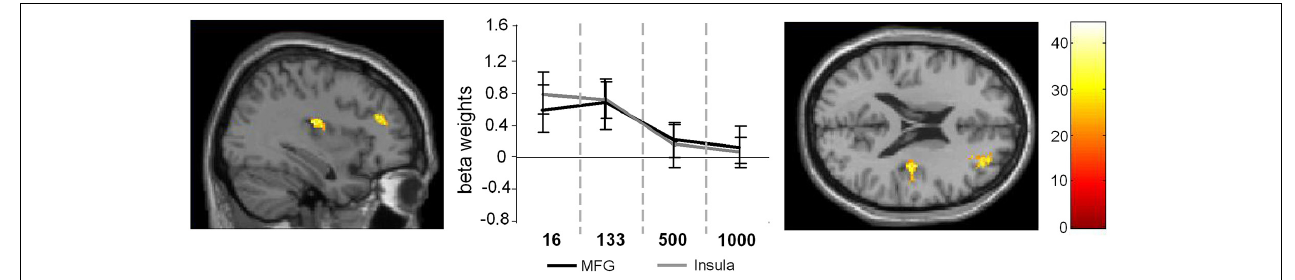
FIGURE 3 | MaineffectofSOA. Theleftpartofthefiguredenotesthefrontalsectionsandthecoronalviewoftheactivatedbrainregions( p < 0 . 001; k > 30voxels). The middle part of the figure denotes the signal intensities (beta weights mean and standard deviation) for these regions across the different SOA conditions.